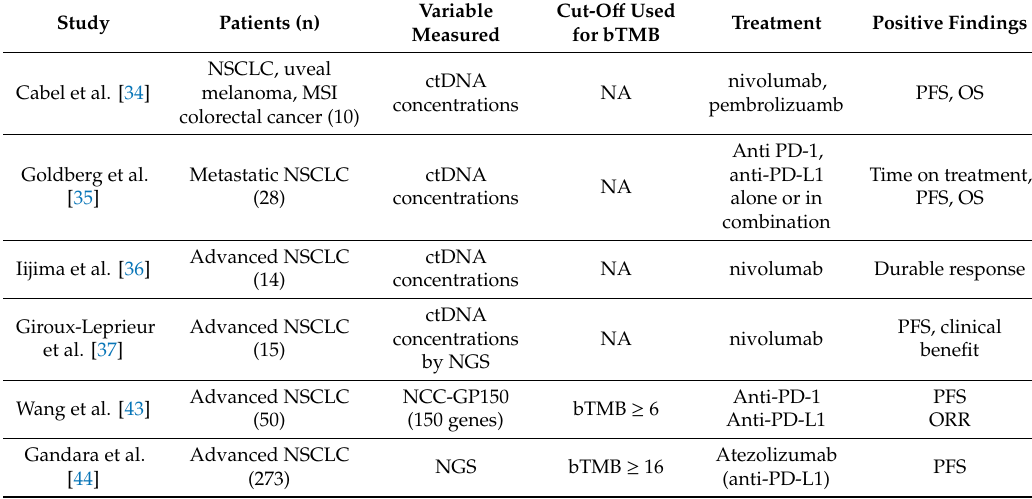
Table 2. Comparison of the di ff erent studies testing circulating tumor DNA (ctDNA) and blood tumor mutational burden